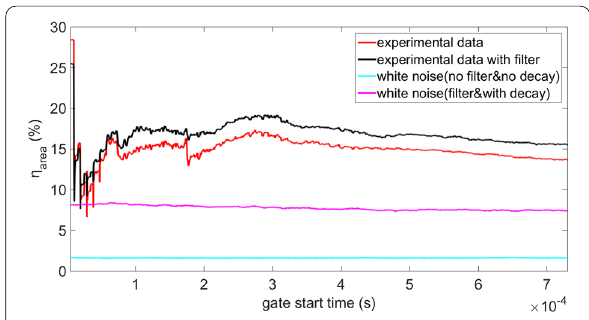
Figure 5 Diffuse field verification on white noise and experimental data using metric η area against gate start time